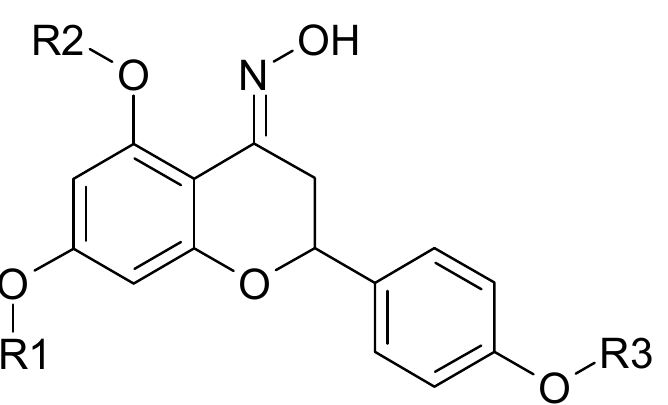
Figure 2. Naringenin oxime and its derivatives. Naringenin oxime: R1 = H, R2 = H, R3 = H (9)